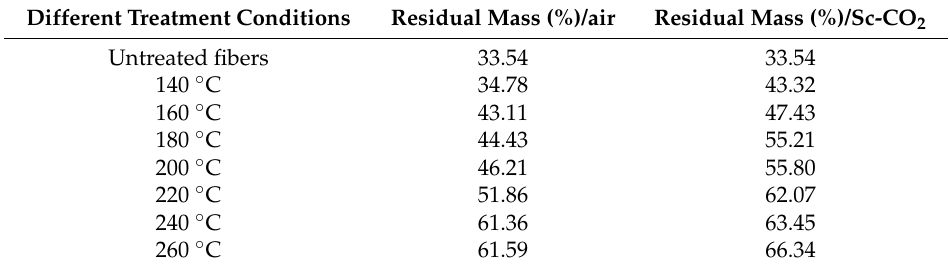
Figure 11. The differential thermal gravity (DTG) curves of PAN fibers treated at different temperatures: ( a ) in Sc-CO 2 ; ( b ) in air. Table 2. Residual mass of the PAN fibers treated in Sc-CO 2 and air. Different Treatment